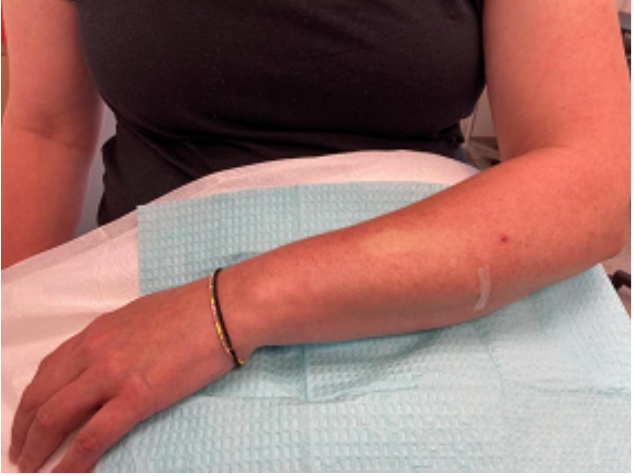
Figure 1 : Left-arm skin thickness.